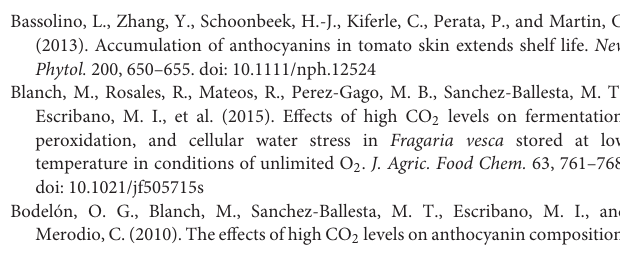
Supplementary Figure 1 | Brix and firmness of “Sonsation” strawberry fruit stored under controlled atmosphere (CA) conditions and shelf life. (A) Brix and (C) firmness at different time points during CA storage at 5 ◦ C and 100% relative humidity. (B) Brix and (D) firmness at different time points of CA storage followed by 3-day shelf life at 12 ◦ C and 100% relative humidity in ambient atmosphere. As a control condition, 21 kPa O 2 and 0 kPa CO 2 were used. Data represent means of 3 blocks ( n = 3) with five replicate fruit per block. The error bars represent the standard error of means. Different letters denote significant differences according to Fisher’s protected LSD test ( α = 0.05). Supplementary Figure 2 | Correlation between pH and firmness of fruit from different CA treatments during storage and subsequent shelf life. The closed black squares represent data of day 0. Data represent individual